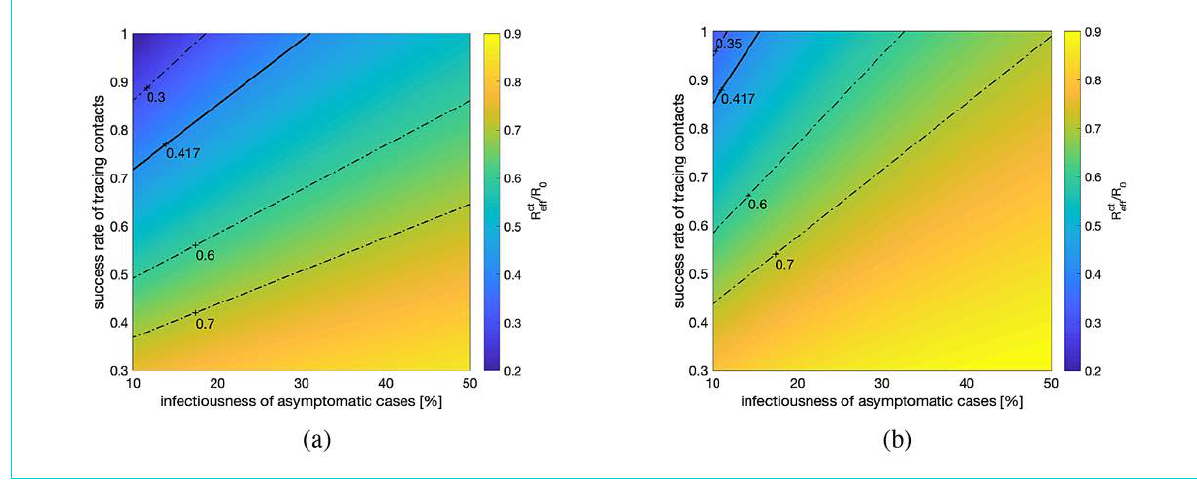
Figure 9: Contact tracing: Effectiveness of contact tracing as a function of relative infectiousness of asymptomatic cases ( the success rate of contact tracing ( ). (a) of infected persons are asymptomatic ( are asymptomatic ( 𝜁𝜁 33% 𝑟𝑟 1 = 0.5